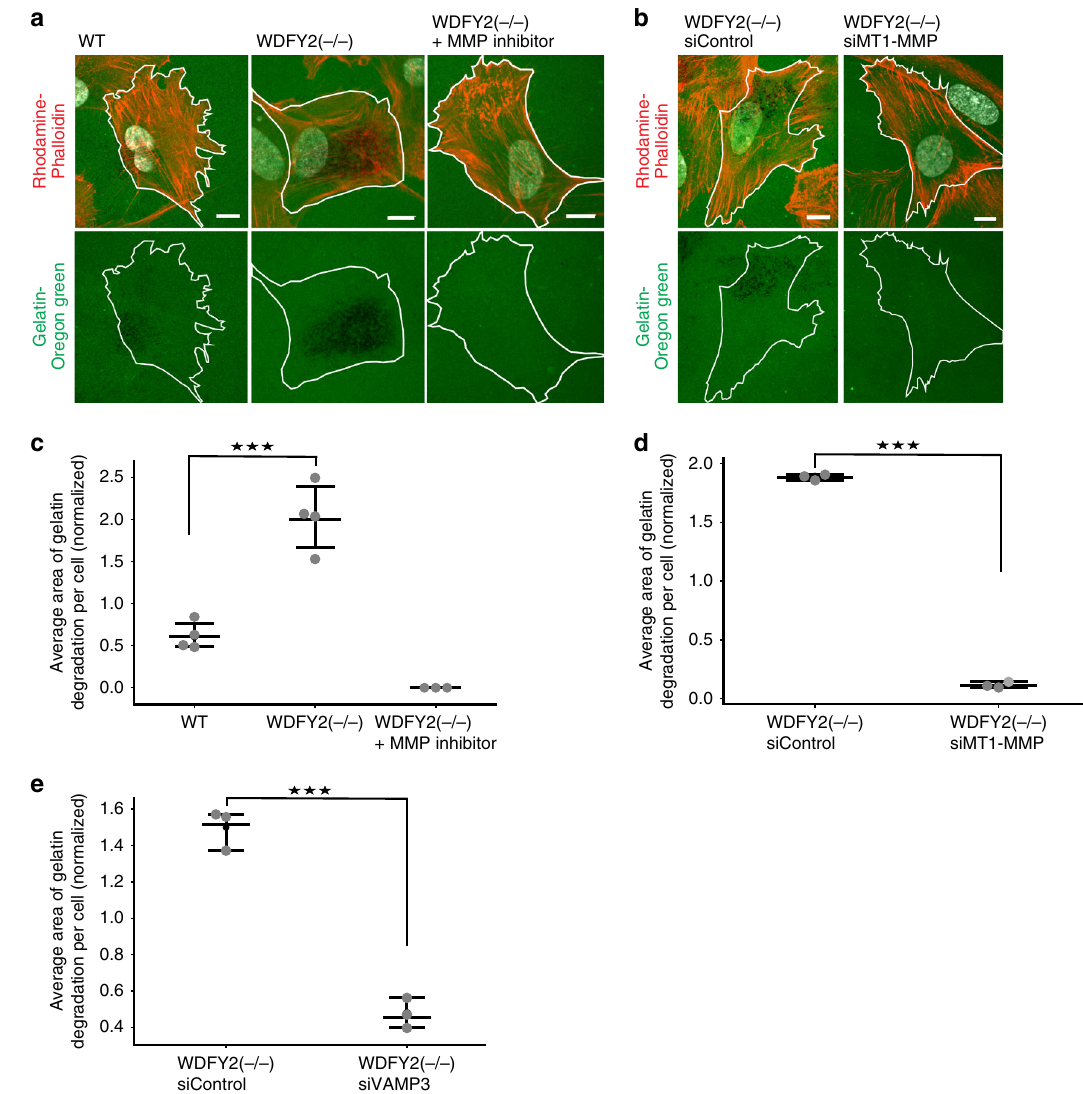
Fig. 7 WDFY2 controls extracellular matrix degradation. a Confocal micrographs showing degradation of a fl uorescent gelatin layer, indicated by dark areas, by WT, WFDY2(-/-) and MT1-MMP-inhibitor treated WFDY2( − / − ) cells. Scale bar: 5 µ m. b Confocal micrographs showing degradation of a fl uorescent gelatin layer, indicated by dark areas, in WDFY2( − / − ) cells treated with control siRNA and MT1-MMP siRNA. Scale bar: 5 µ m. c Quanti fi cation of gelatin degradation shown in ( a ). The graph shows average area of gelatin degradation per cell. n = 4 experiments, representing in total 815 cells (WT), 741 cells (WDFY2( − / − )) and 221 cells (WDFY2( − / − ) + MMP inhibitor). Data points indicate the mean degradation per experiment, also shown is the mean ± 95% CI. Student ’ s unpaired t test, p = 0.00057. * p < 0.05, ** p < 0.01, *** p < 0.001, n.s. not statistically signi fi cant. d Quanti fi cation of gelatin degradation shown in ( b ). The graph shows average area of gelatin degradation per cell n = 3 experiments, representing 543 cells (WDFY2( − / − ) siControl) and 455 cells (WDFY2( − / − ) MT1-MMP siRNA) in total. Data points indicate the mean degradation per experiment, also shown is the mean ± 95% CI. Student ’ s unpaired t test, p = 1.028e − 07. * p < 0.05, ** p < 0.01, *** p < 0.001, n.s. not statistically signi fi cant. e Quanti fi cation of gelatin degradation in WDFY2( − / − ) cells treated with control siRNA and VAMP3 siRNA. The graph shows average area of gelatin degradation per cell n = 3 experiments, representing 618 cells (WDFY2( − / − ) siControl) and 610 cells (WDFY2( − / − ) VAMP3 siRNA) in total. Data points indicate the mean degradation per experiment, also shown is the mean ± 95% CI. p = 0.0002164. Student ’ s unpaired t test, * p < 0.05, ** p < 0.01, *** p < 0.001, n.s. not statistically signi fi cant. Source data are provided as a Source Data fi